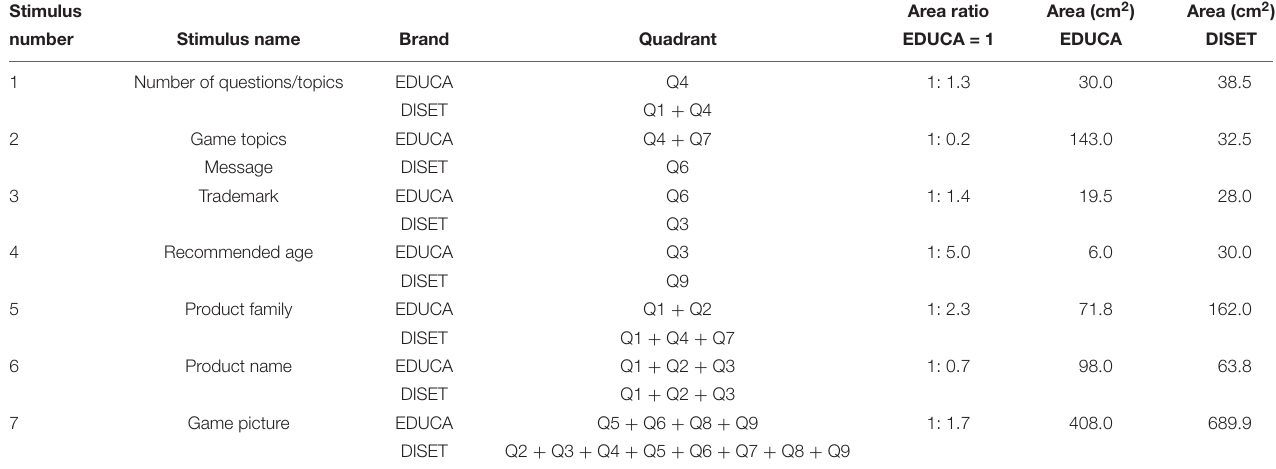
TABLE 1 | Common stimuli by brand, location quadrant, and size